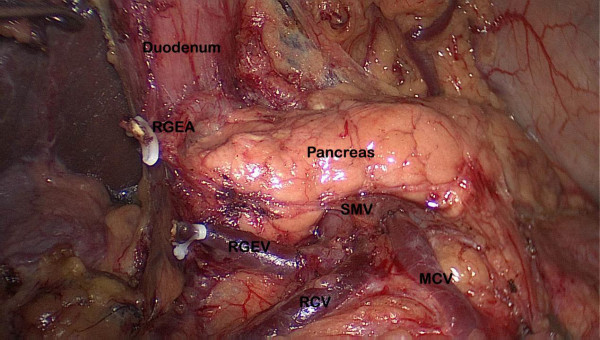
Dissection of the lymph node numbers 14v and 6. MCV: middle colic vein; RCV: right colic vein; REGV: right gastroepiploic vein; RGEA: right gastroepiploic artery; SMV: superior mesenteric vein.